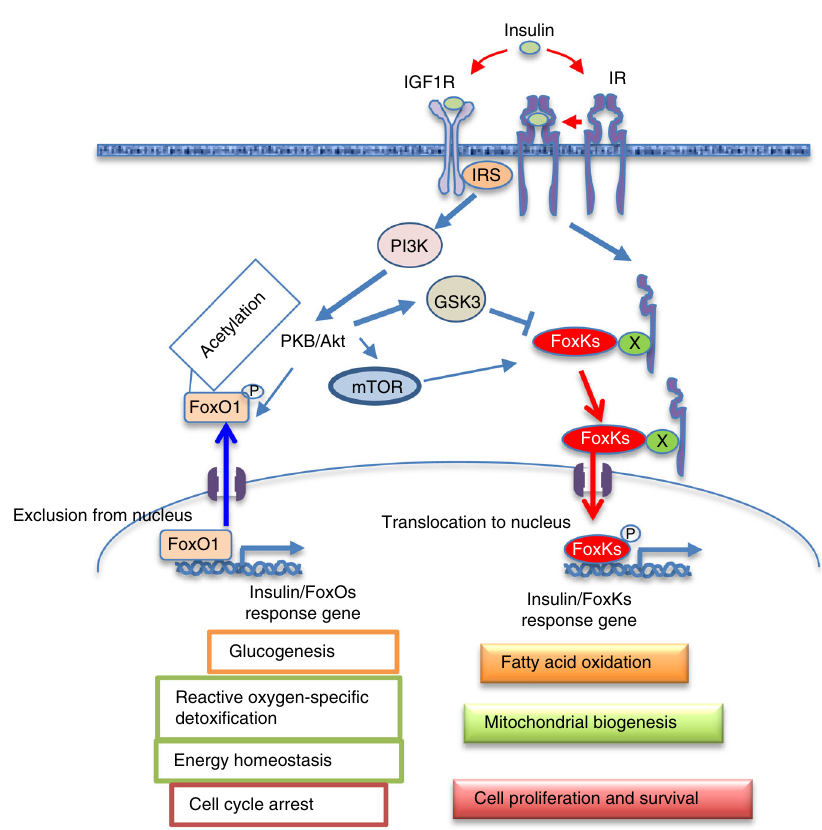
Fig. 8 Schematic model of insulin regulation of FoxK1/K2 and FoxOs in cellular function. The FoxK Forkhead transcription factors translocate from the cytoplasm to nucleus reciprocally to the translocation of FoxO1. FoxK translocation to the nucleus is dependent on the Akt-mTOR pathway, while its localization to the cytoplasm in the basal state is dependent on GSK3. Once in the nucleus, FoxKs play important roles in regulation of genes, fatty acid oxidation, mitochondrial biogenesis, cell proliferation and survival. Where other unknown proteins (named here X) are in the FoxK and IR/IGF1R protein- protein complexes remains to be